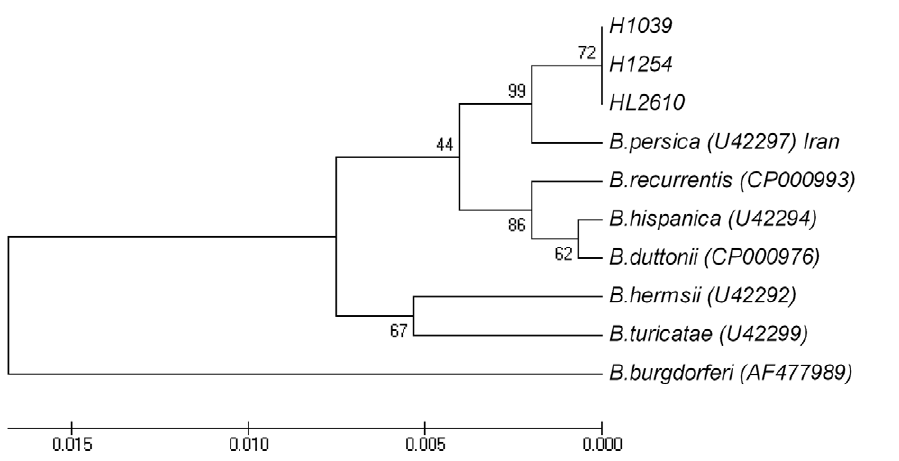
Figure 4. Phylogenic tree based on rrs sequences. The complete rrs sequences of B. persica isolates in Israel were compared to rrs sequences from B. persica (Iran) and other Borrelia species (accession numbers are given in parentheses). The phylogenic tree was inferred using the UPGMA method. Parameters were as described in Figure 2. All positions containing gaps and missing data were eliminated from the dataset (Complete deletion option). There were a total of 1522 positions in the final dataset.